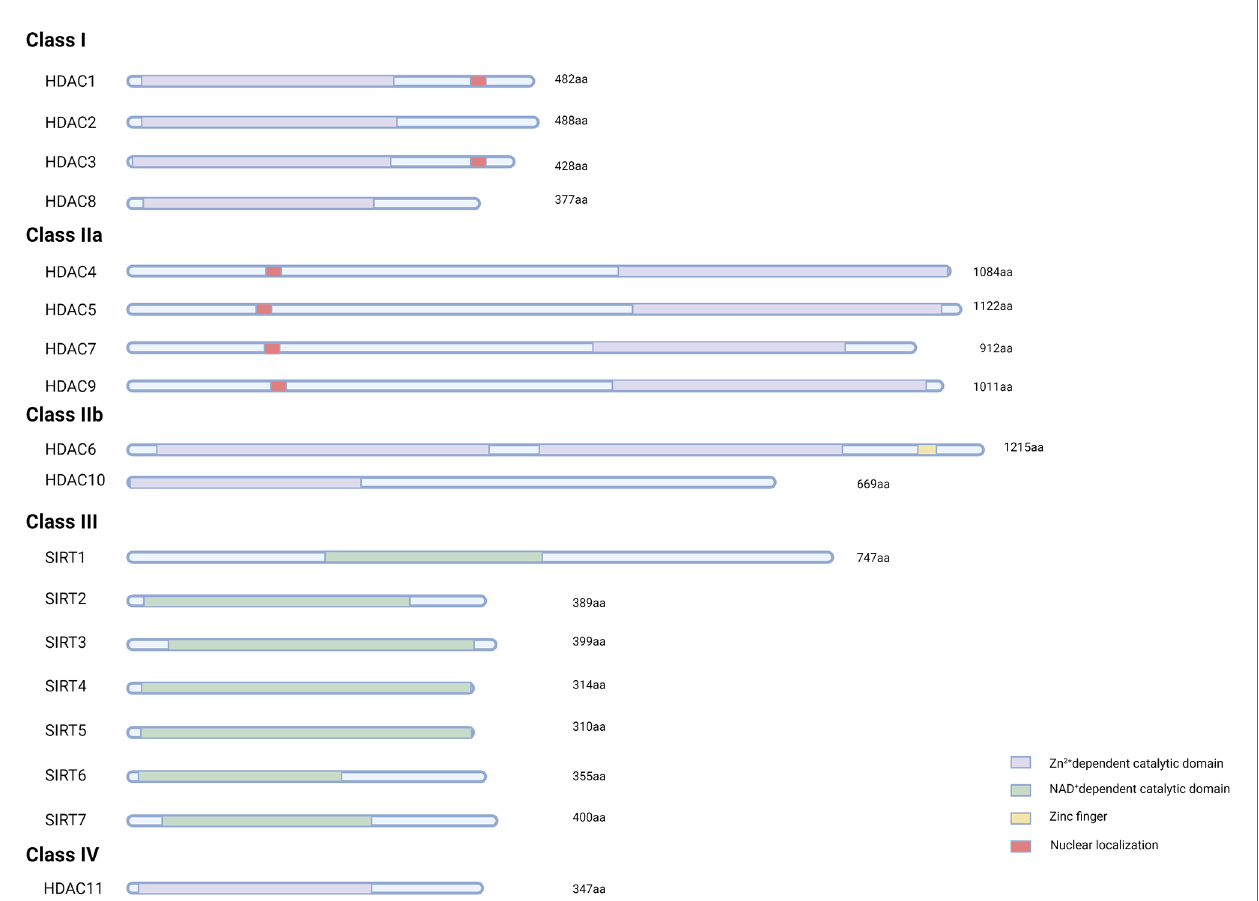
FIGURE 2 | The domain structure of human HDACs. The basic domain structure of eighteen HDAC members. Class I, II, and IV HDACs contain Zn 2+- dependent domains, while SIRTs contain NAD +- dependent domains. Nuclear localization sequences and zinc fi nger motifs in different HDACs are also